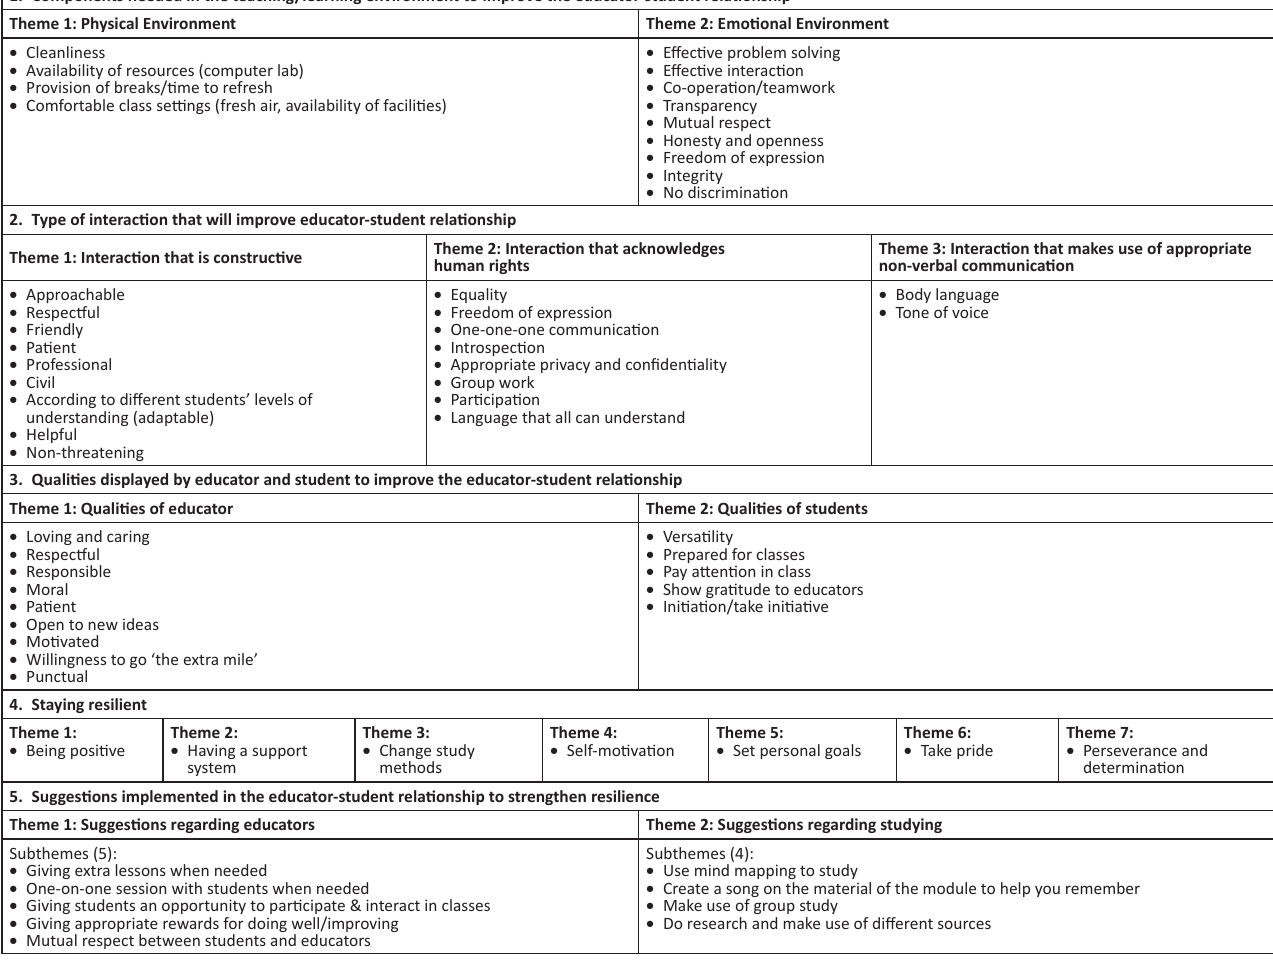
FIGURE 1: Themes: World café posters and